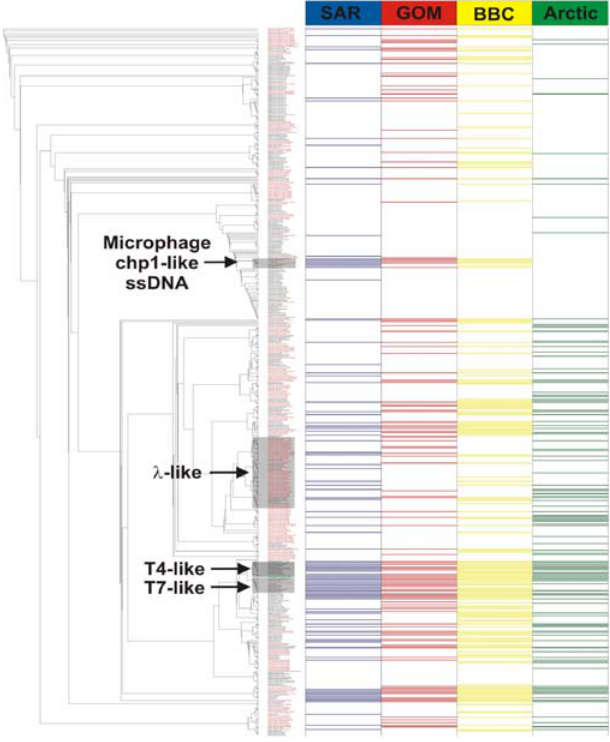
Figure 4. Types of Phages in the Four Metagenomes A new version of the Phage Proteomic Tree (left panel) was constructed from 510 complete phage and prophage genomes using the previously described method [23]. The metagenomic sequences were compared to the phage on the Phage Proteomic Tree using TBLASTX, and the colored bars on the right represent significant similarities ( E -value , 0.0001). Names of prophages are in red and the Prochlorococcus phage genomes are in green. An electronic version of the tree and a FASTA list of phage and prophage genomes used to make the tree are available at the SDSU Center for Universal Microbe Sequencing website (http://scums.sdsu.